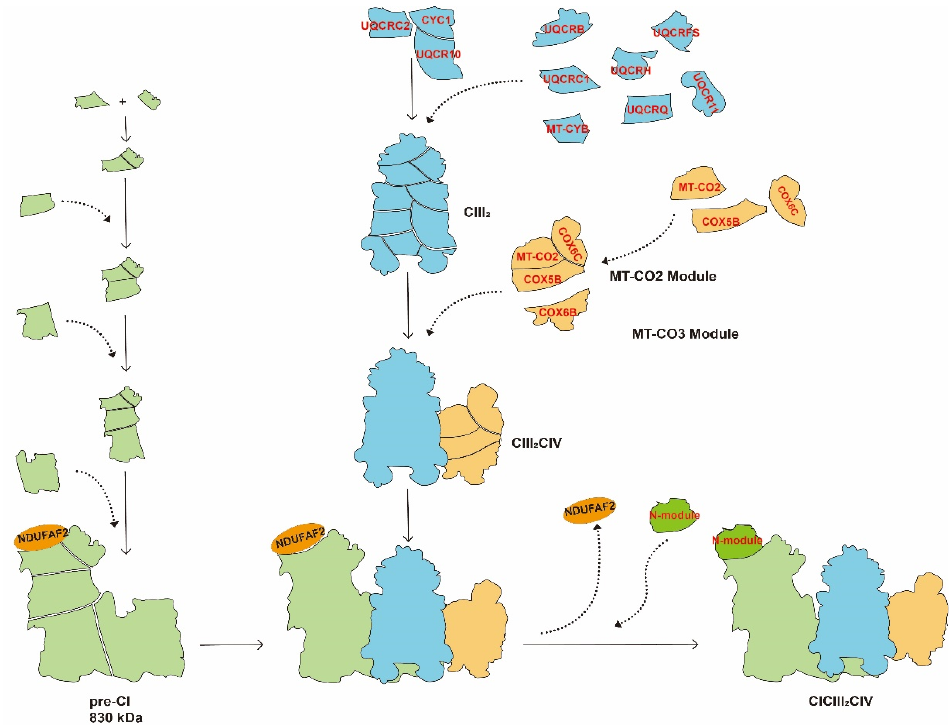
Figure 3. Assembly of CICIII 2 CIV by the cooperative ‐ assembly model. CYC1, QUCRC2,